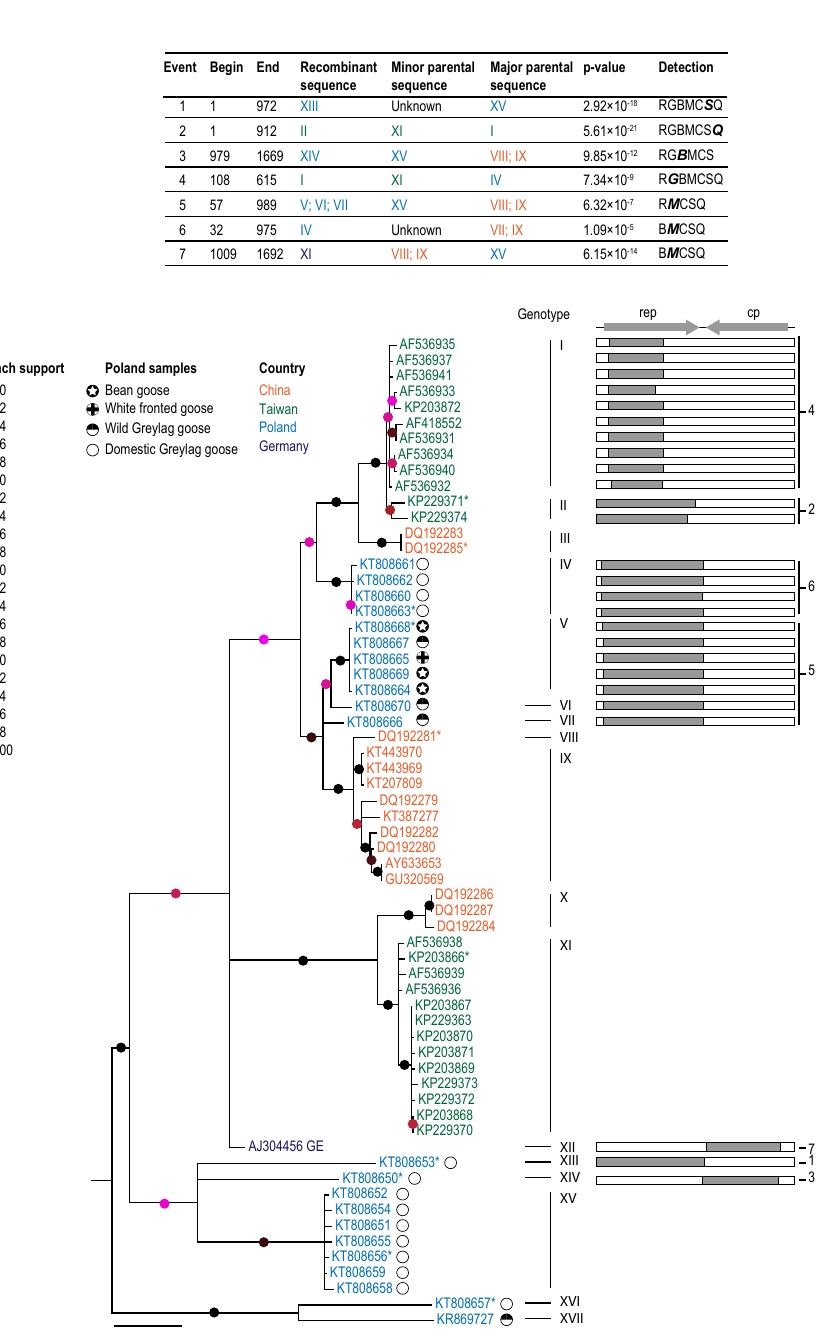
Figure 2. ( A ) A summary of the seven recombination events detected using the RDP (R), GENECONV (G), BOOTSCAN (B), MAXCHI (M), CHIMAERA (C), SISCAN (S), and 3SEQ (Q) methods implemented in the computer program RDP4. Only detection methods with associated p -values < 0.05 are shown. The p -value is for the detection method shown in bold italics. ( B ) Recombination free Maximum likelihood phylogenetic tree (left) with a cartoon illustration of the associated recombination event. Genome sequences used in DNA secondary structure analysis are marked with